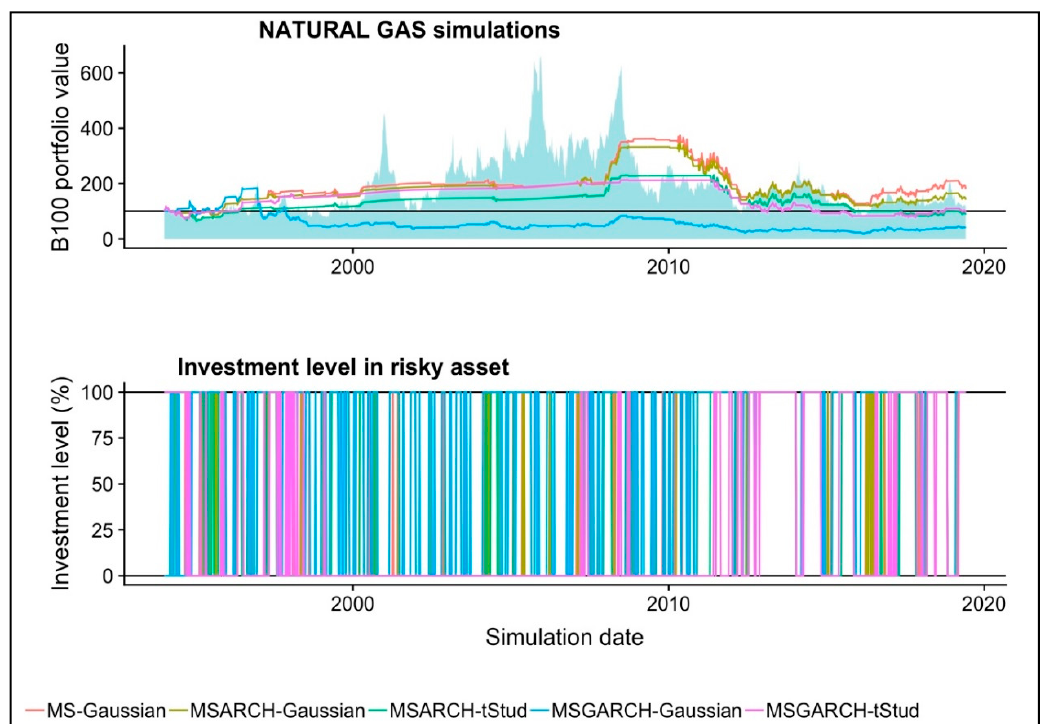
Figure 3. Historical performance of the five simulated scenarios of the investment strategy in the natural gas price one-month future and its historical investment level. Source: Own elaboration with results of our simulations and data from Refinitiv Eikon [72]. Table 9. ANOVA and Kruskal–Wallis test of the observed weekly returns in the simulated portfolios of the NATGAS price and the USTBILL portfolio.